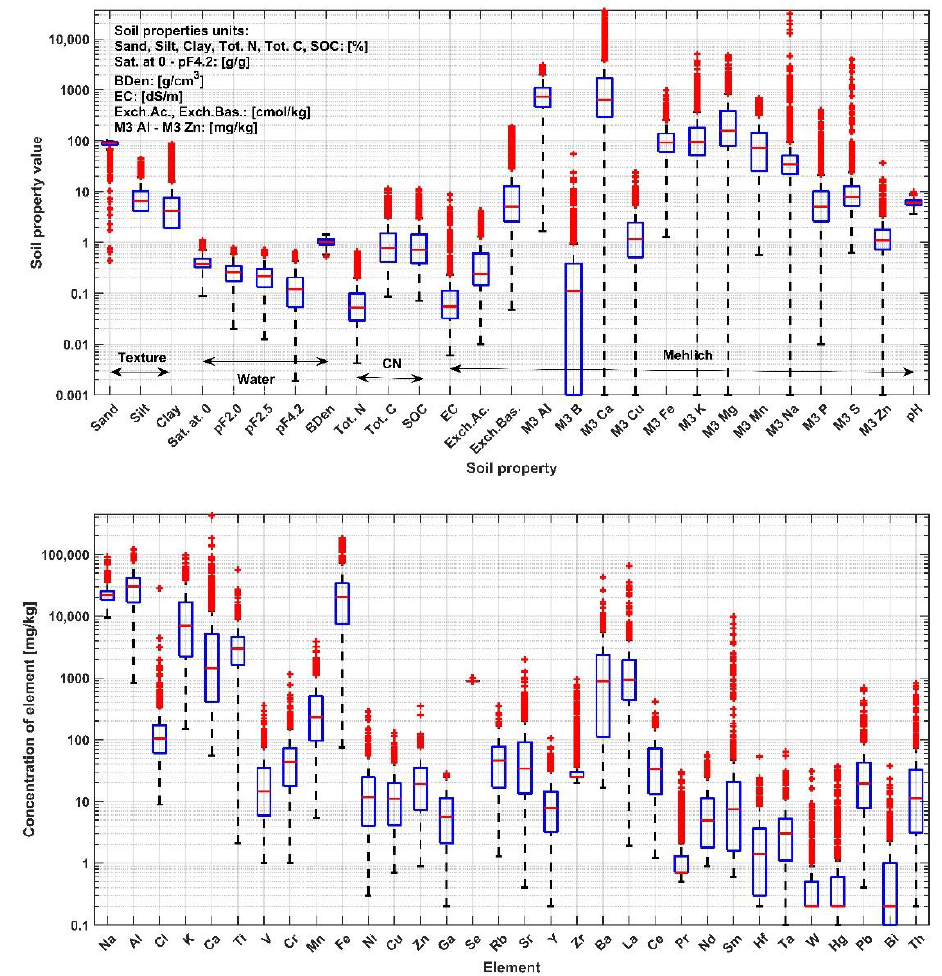
Figure 2. Box plots for modeled soil properties divided into separate data groups, i.e., Elements, Texture, Water, CN, and Mehlich. Blue boxes represent values between first and third quartile, red line represents median value and red crosses represent values outside the range of first quartile minus 1.5 times interquartile range and third quartile plus 1.5 times interquartile range.